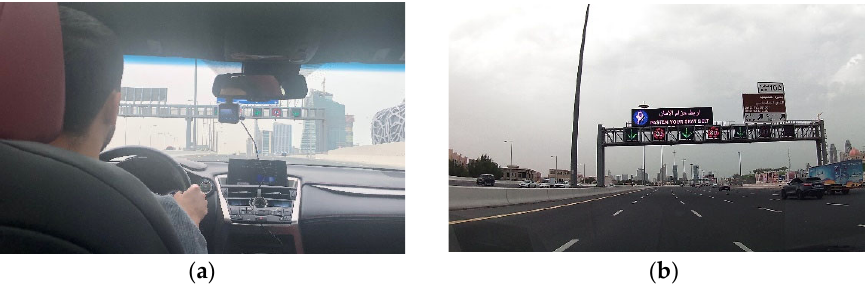
Figure 1. ( a ) Vehicle setup; ( b ) Screenshot from recorded video.